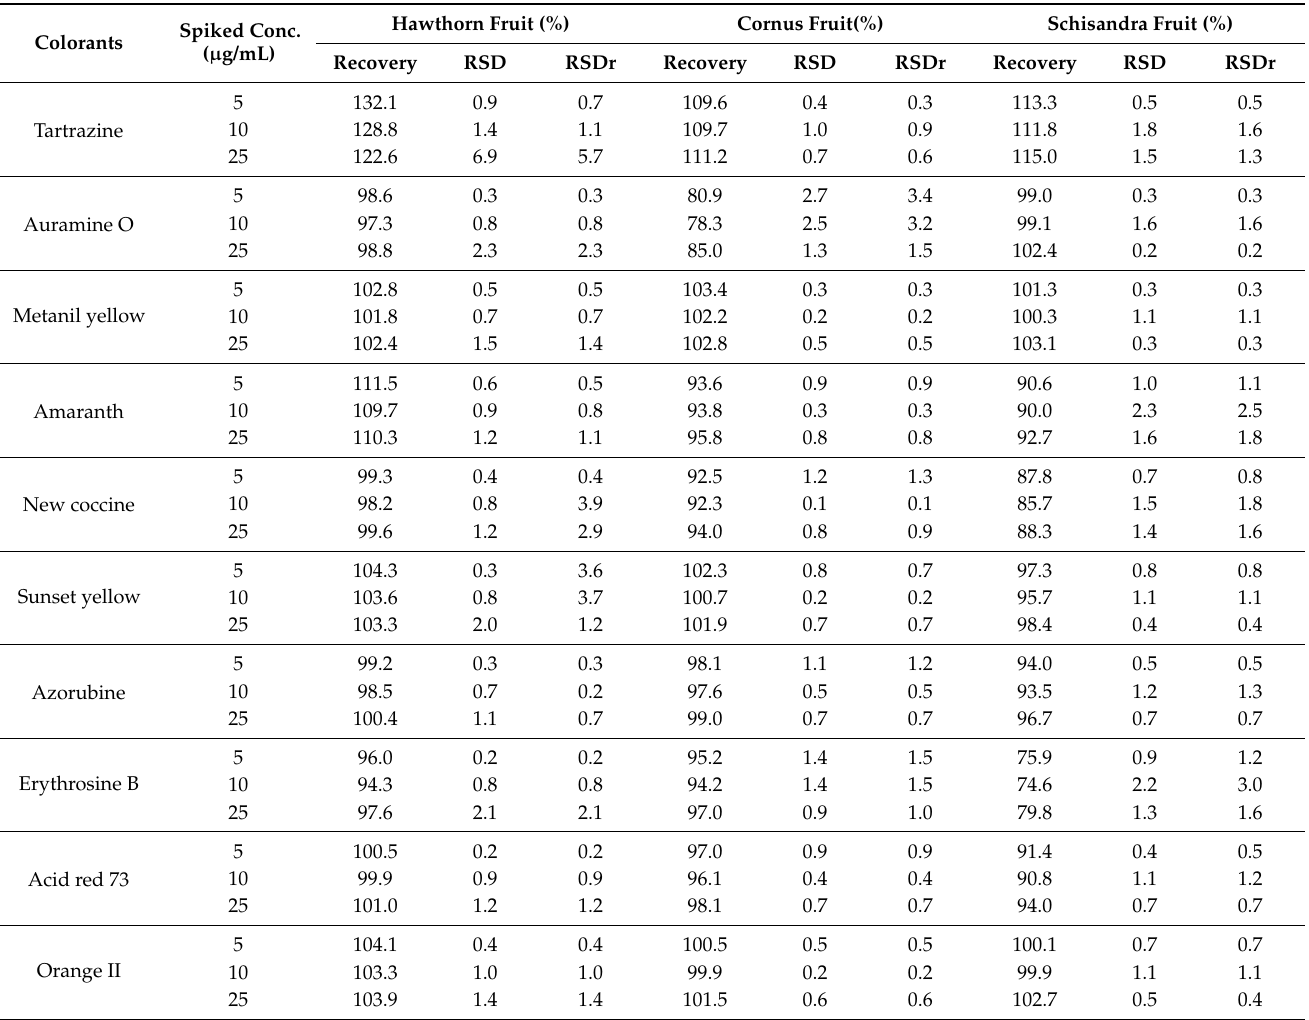
Table 3. Intra-day recoveries and precisions obtained from the proposed HPLC-PDA analysis method in three herbal medicines. Hawthorn Fruit (%) Cornus Fruit(%) Schisandra Fruit Spiked Conc. Colorants ( µ g/mL)